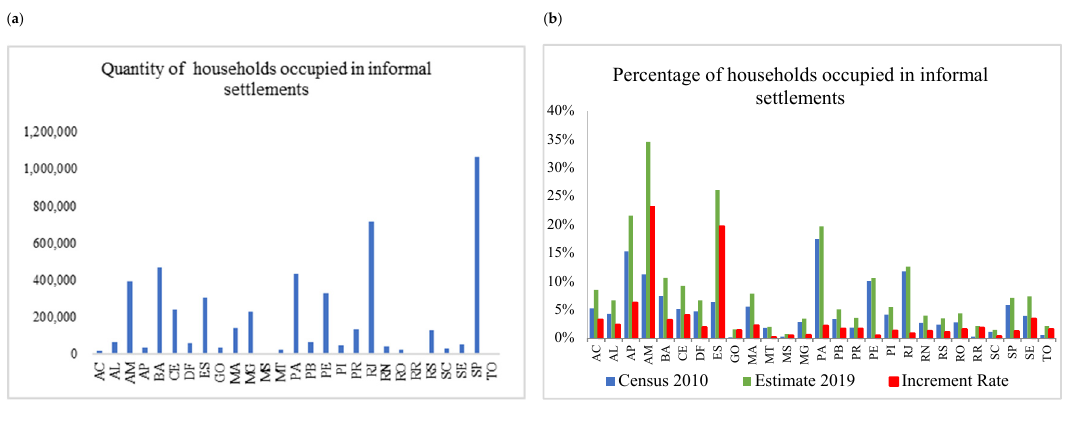
Figure 1. Private households and informal settlements by federal state ( a , b ). The best indicators of access to water are observed in the federal district and in the states of São Paulo and Paraná with more than 90% coverage. However, the information disclosed considers the indicator of apparent coverage. Since most informal settlements do not have adequate services, they remain out of the quality standards and show low willingness to pay. When considering informal settlements, the actual water access percentages are much lower. For example, in Manaus, the apparent water coverage is 81% while the real water coverage is 46%. The same occurs in all Brazilian states. In Esp í rito Santo, for example, the apparent water coverage is 81%, and the real water coverage is 55%. In Rio de Janeiro, the apparent water coverage is 87%, and the real water coverage is 74%. The same rationale applies to the coverage indicators of sanitation services where apparent coverage indicators are much lower than those of the water supply service. Figure 2 shows the apparent and actual water coverage indicators for all states of the federation and the federal district. Thus, the need to recognize that a general expansion of WSSs is necessary should consider equal and inclusive universalization with robust projects that provide access to WSSs, even to poor and vulnerable